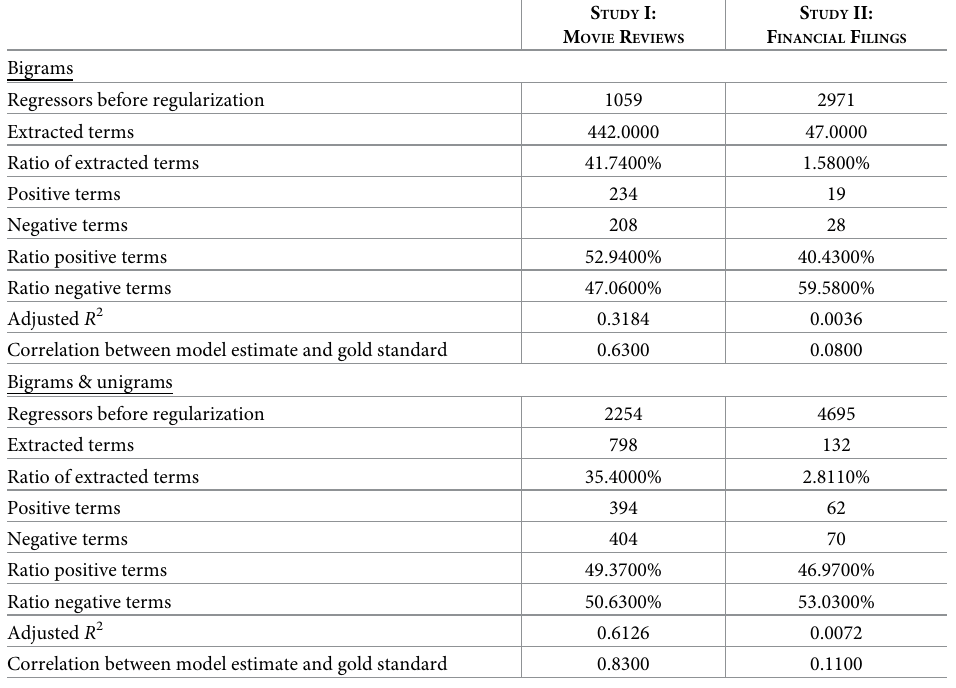
Table 5. Summary statistics of statistical inferences with word